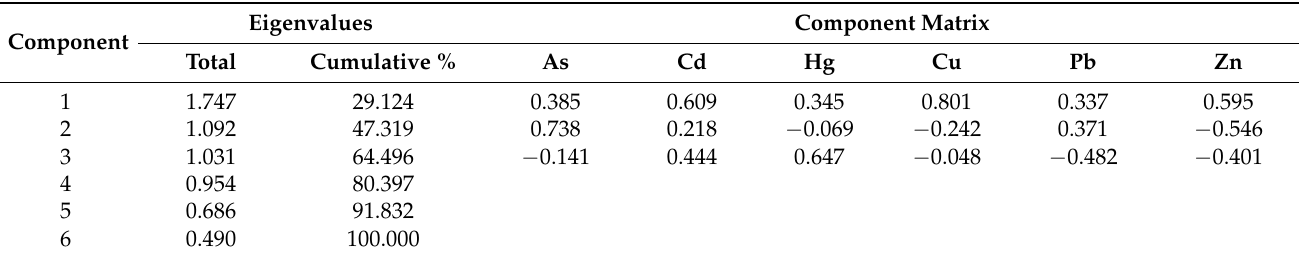
Table 3. PCA results for six heavy metals in Shunyi District.